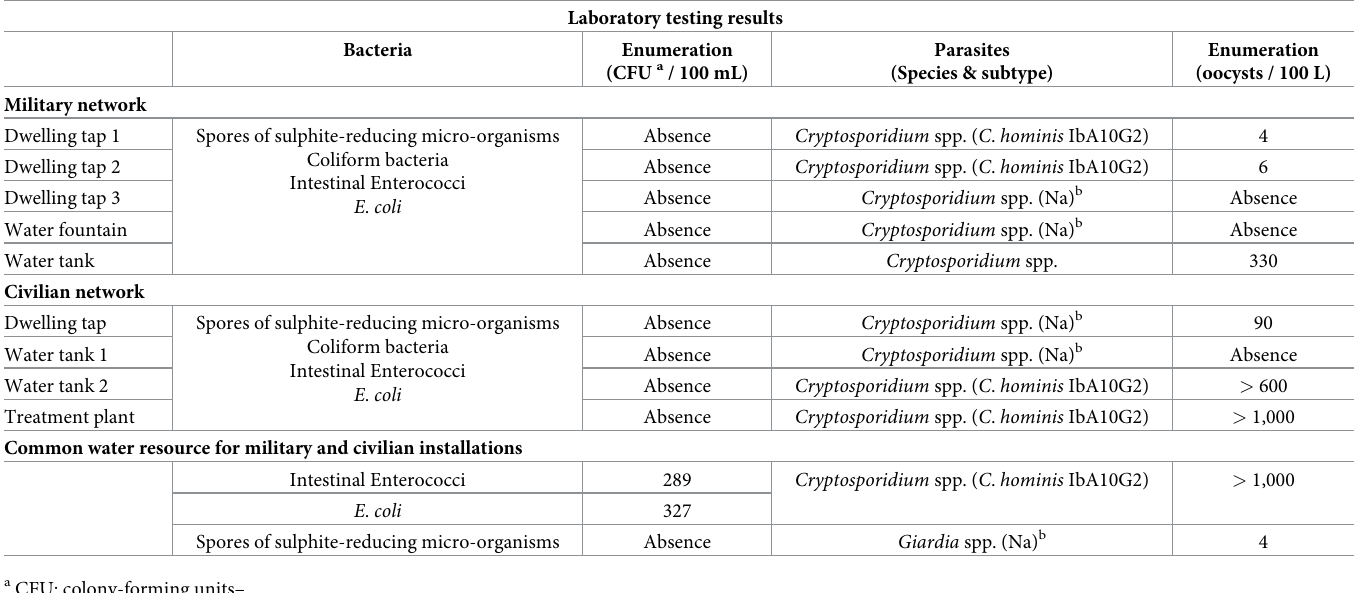
Table 3. Cryptosporidiosis outbreak, laboratory testing of water samples, France,